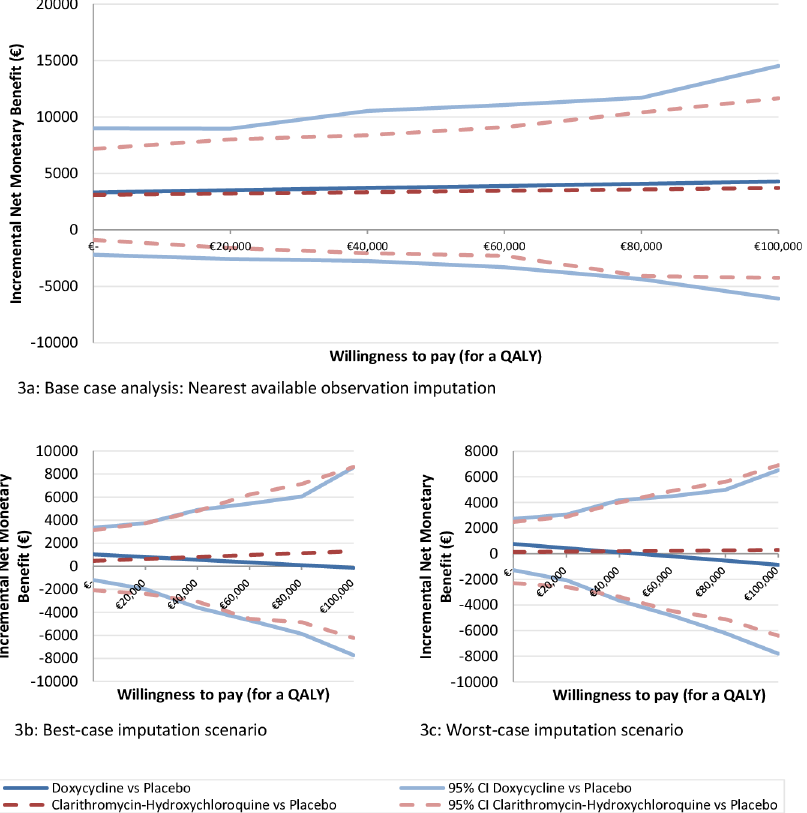
Fig 3. a. Base case analysis: Nearest available observation imputation. b. Best-case imputation scenario. c. Worst-case imputation scenario.